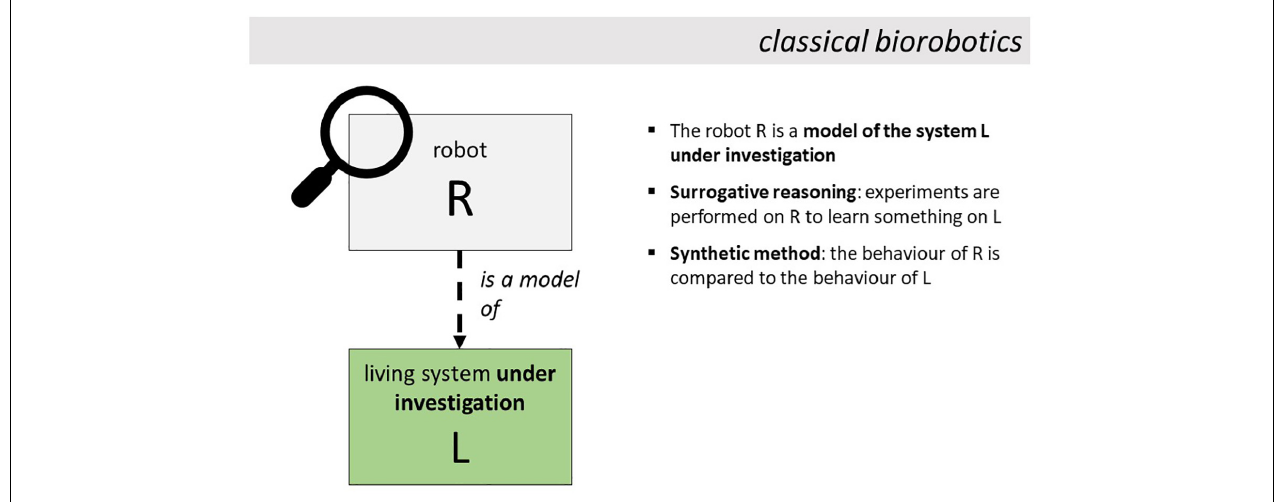
FIGURE 1 | In classical biorobotics, the robot is a model of the living system under investigation and is used to perform surrogative reasoning on it. Experiments are performed on R (as represented by the position of the lens). The behavior of the robot is compared to the behavior of the system L under